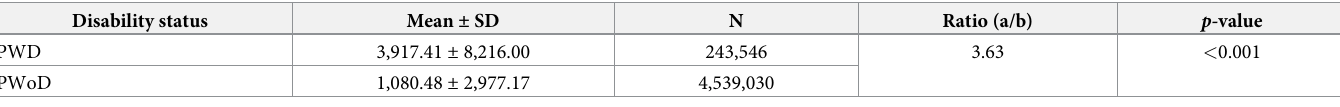
Table 2. Average medical care cost of the study subjects by disability status